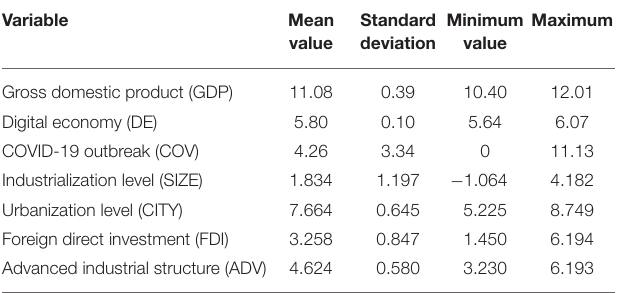
TABLE 3 | Descriptive statistics of